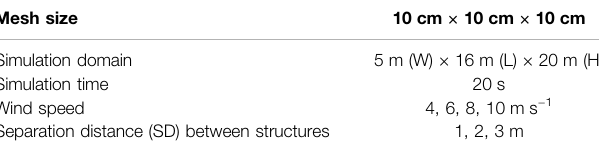
TABLE 1 | Conditions for FDS